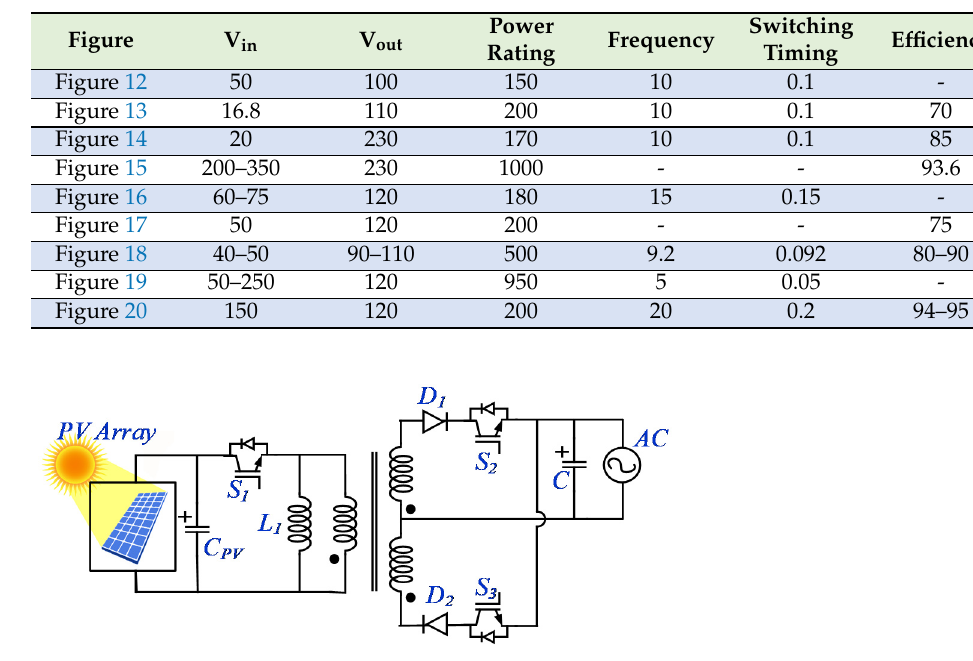
Table 2. Comparative study on ratings of single-stage inverter topologies.